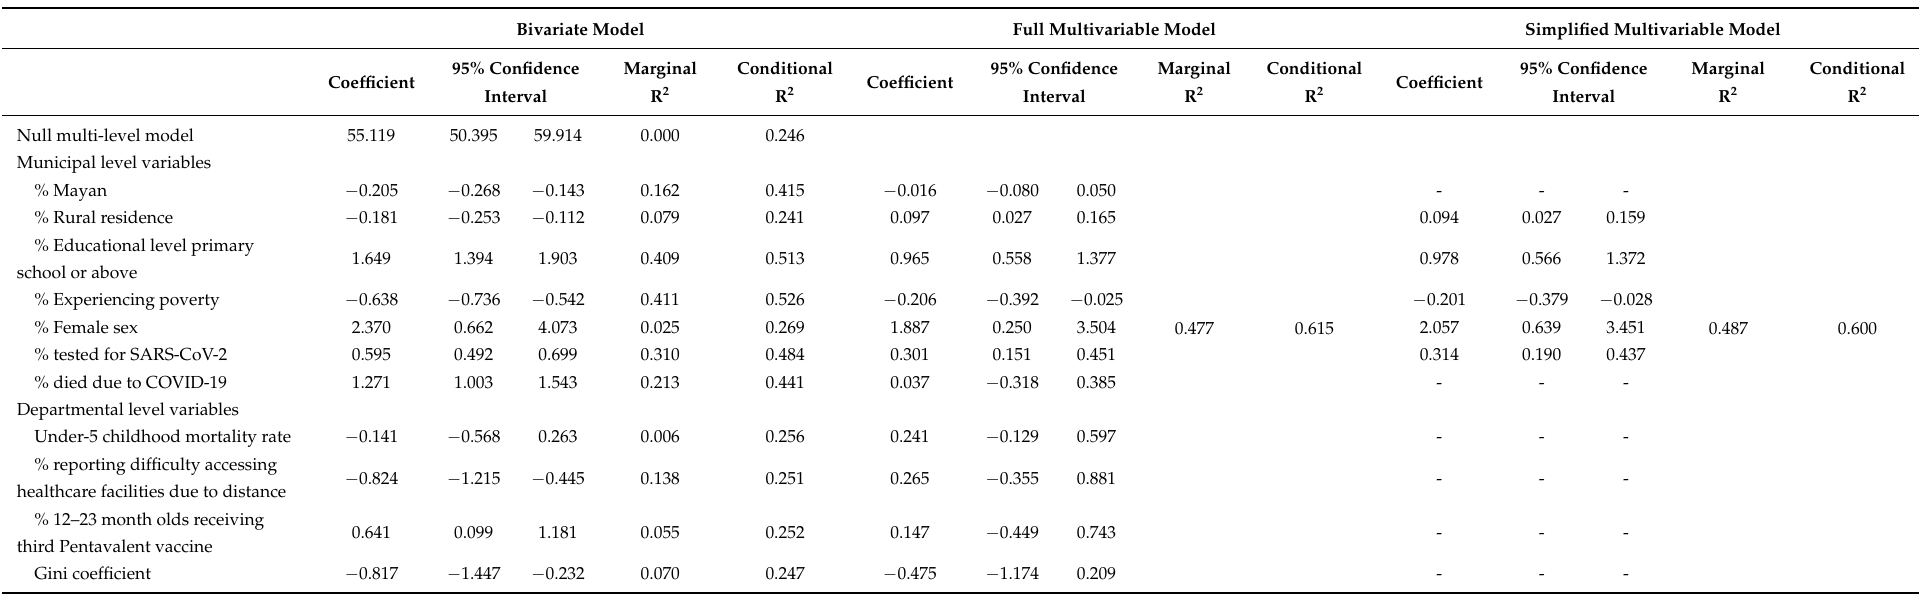
Table 4. Association between sociodemographic factors (by municipalities and departments) and two-dose vaccination coverage (%) among patients aged 60 years or older by municipalities in Guatemala (N = 336). SARS-CoV-2 case and vaccination data are from 13 February 2020 to 30 November